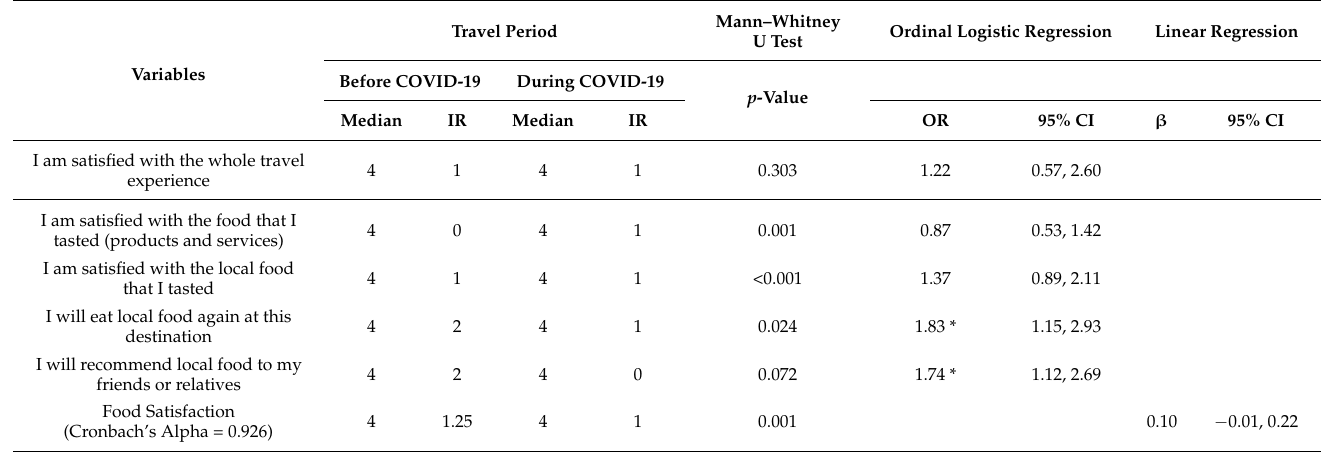
Table 8. Tourists’ level of satisfaction by the trip as a whole and by the food